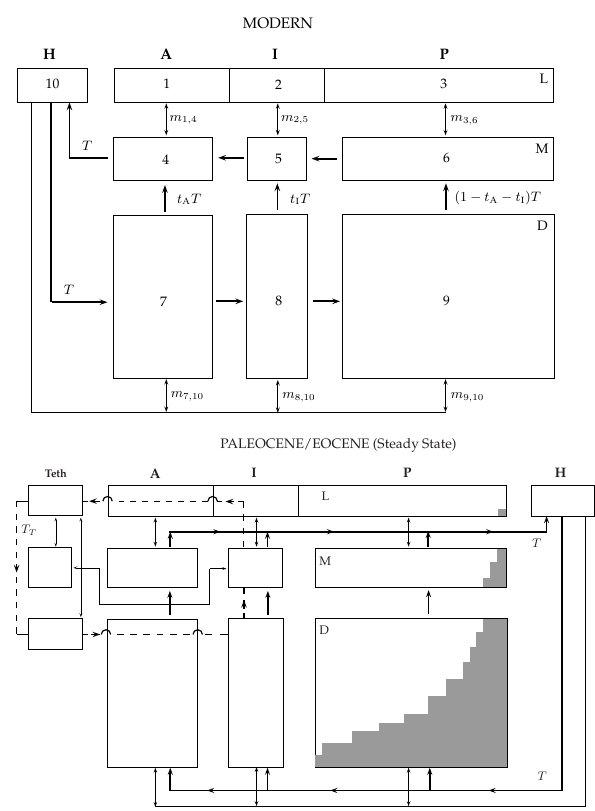
Fig. 2. Ocean circulation and mixing schemes implemented in LOSCAR for modern setup (top) and Paleocene/Eocene (P/E) steady-state (bottom). A = Atlantic, I = Indian, P = Pacific ocean, H = High-latitude surface, Teth = Tethys. L = Low-latitude sur- face, M = interMediate, D = Deep box. T represents the conveyor transport, while the coefficients m lk represent bidirectional mixing between boxes. The generic H-box represents cold surface waters without reference to a specific location. Nevertheless, the modern setup is motivated by preindustrial circulation patterns with signif- icant deep water formation in the North Atlantic (e.g. Walker and Kasting, 1992; Toggweiler, 1999). The P/E steady-state setup is in- spired by observations and modeling studies of Paleocene/Eocene circulation patterns with significant deep water formation in the Southern Ocean (e.g. Bice and Marotzke, 2002; Thomas et al., 2003; Lunt et al., 2010). T T (dashed line) represents the Tethys circulation, which connects to the Indian Ocean (note that the T T - surface and deep branch do not flow through Atlantic boxes, as in- dicated by arcs). Note also that a transient contribution of North Pacific Deep Water (not shown) was included in our PETM sim- ulations (Zeebe et al., 2009). All ocean boxes (except H-box) in the modern and P/E-setup are coupled to sediment boxes (schemat- ically indicated only in the bottom panel for the Pacific by the gray shaded